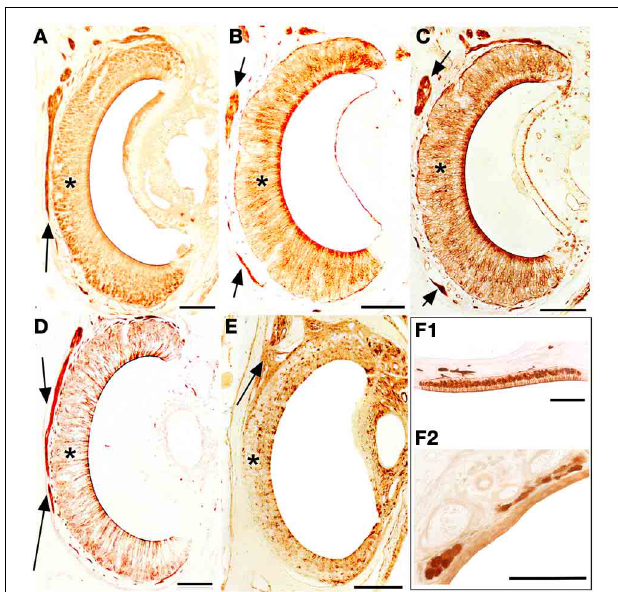
FIGURE 10 | Transverse sections of the vomeronasal duct stained with anti-OMP (A), UEA-I (B), LEA (C), anti-G α 0 (D) and anti-G α i 2 (E), and of the septal organ (F 1 ) and Grüneberg ganglion (F 2 ) stained with anti-OMP. Arrows indicate vomeronasal nerve axons medial to the vomeronasal sensory epithelium (asterisk). Scale bars: 100 μ m.